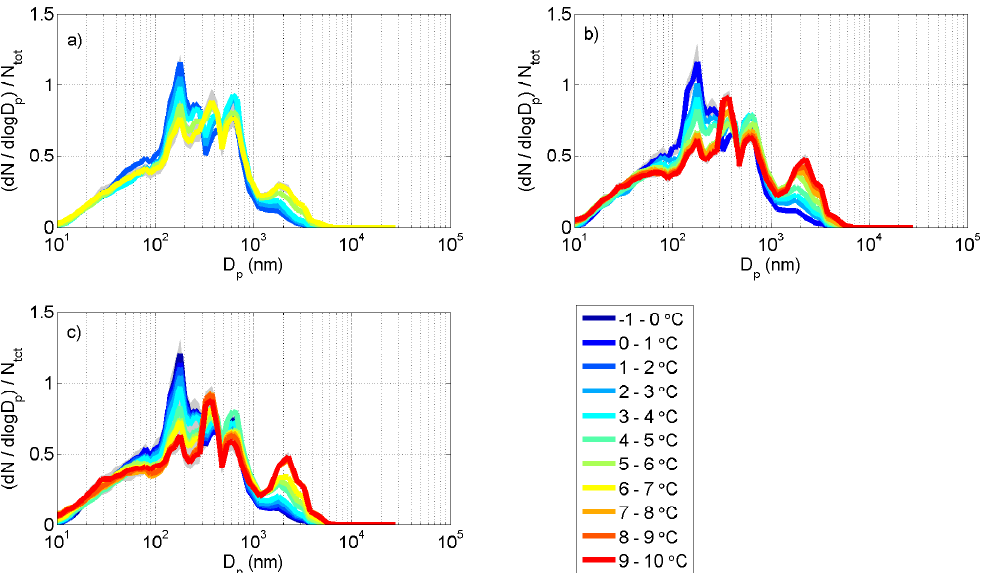
Fig. 11. Normalized number size distributions for winter experiments resulting from bubble bursting of (a) deep fjord water, (b) water sampled close to the glacier and (c) water sampled at the fjord mouth. Grey shaded areas represent the interquartile range for the lowest and highest water temperature range. The same grey shade is used for both temperature ranges and indicates if there is an obvious difference between the particle number concentrations of different sizes of the lowest and highest water